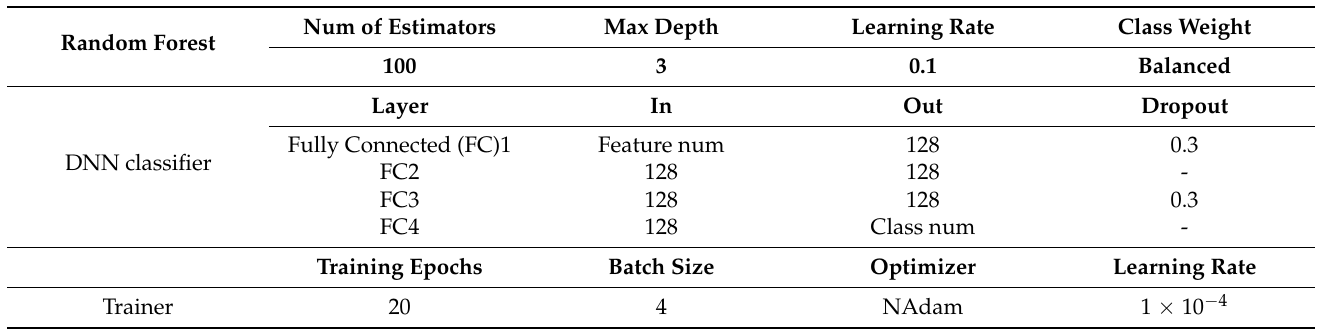
Table 4. Parameters values in this